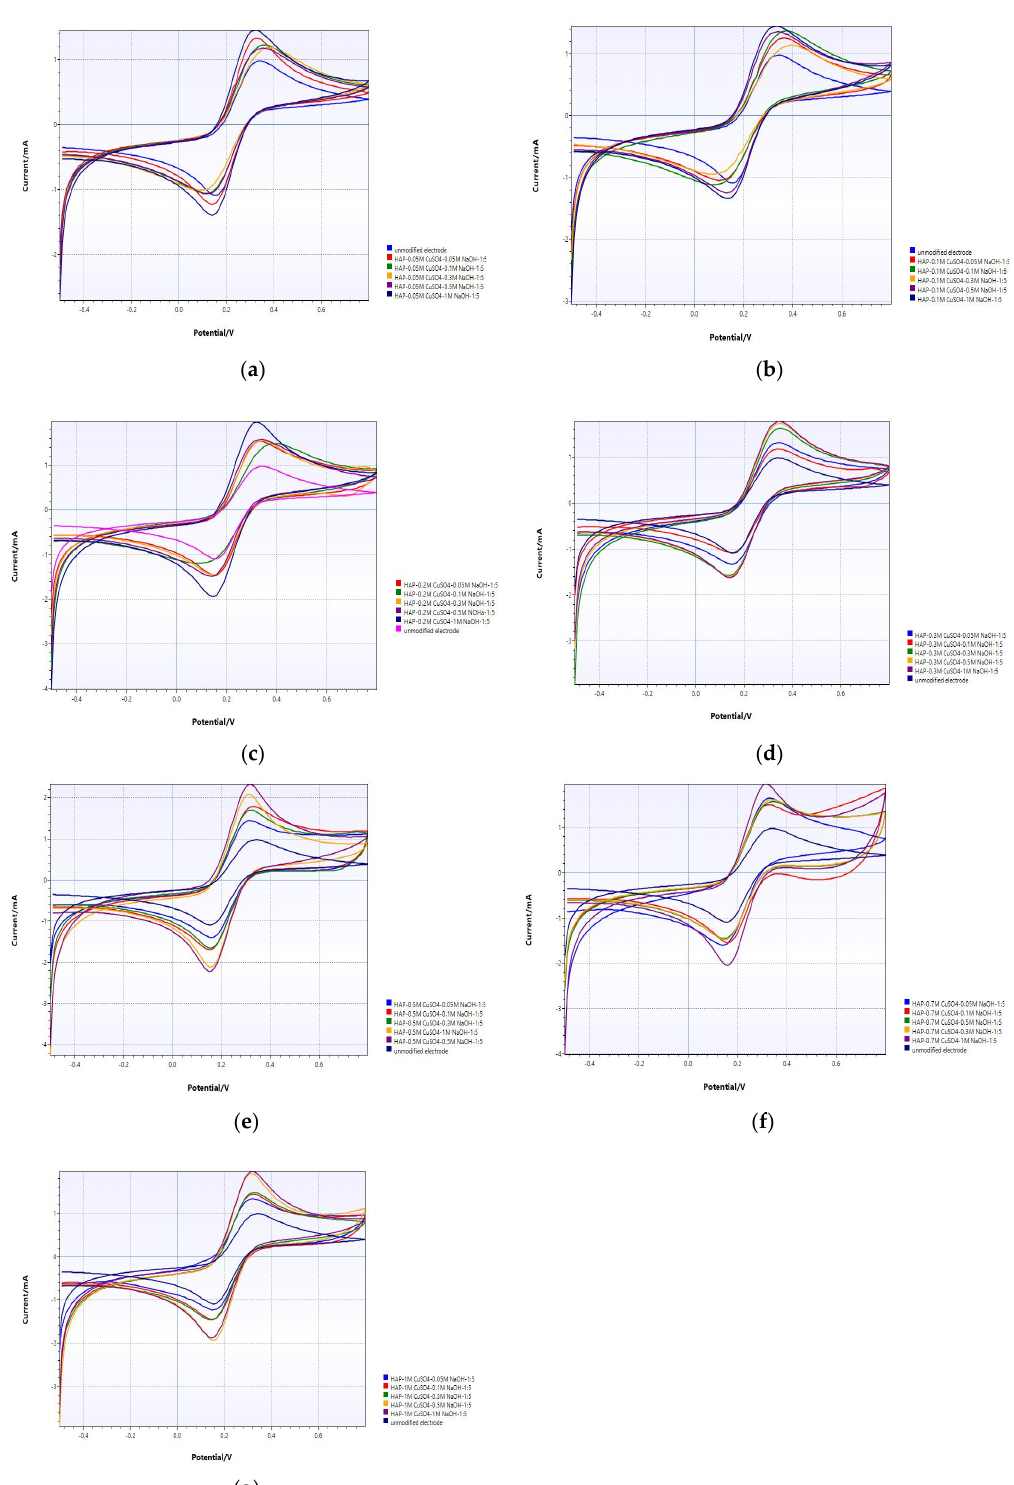
Figure 3. CV analysis of unmodified PGE and ( a ) HAP-PGE modified in 0.05 M CuSO 4 and different concentrations of NaOH; ( b ) HAP-PGE modified in 0.1 M CuSO 4 and different concentrations of NaOH; ( c ) HAP-PGE modified in 0.2 M CuSO 4 and different concentrations of NaOH; ( d ) HAP-PGE modified in 0.3 M CuSO 4 and different concentrations of NaOH; ( e ) HAP-PGE modified in 0.5 M CuSO 4 and different concentrations of NaOH; ( f ) HAP-PGE modified in 0.7 M CuSO 4 and different concentrations of NaOH; and ( g ) HAP-PGE modified in 1 M CuSO 4 and different concentrations of